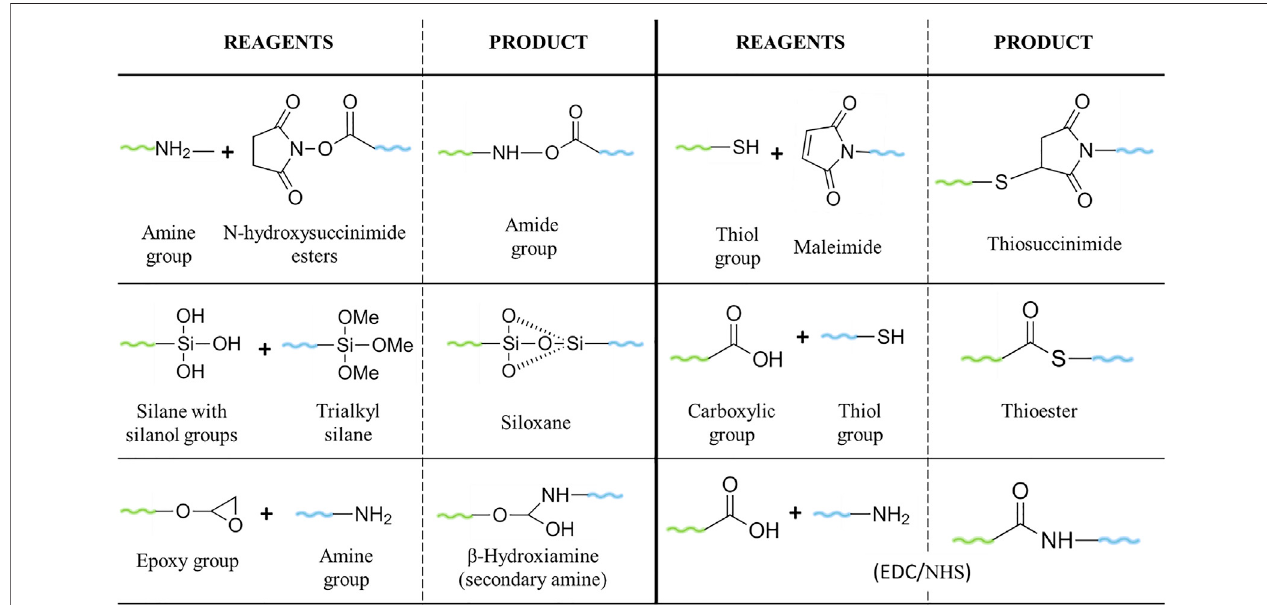
FIGURE 2 | Common reactions for PEGylation of